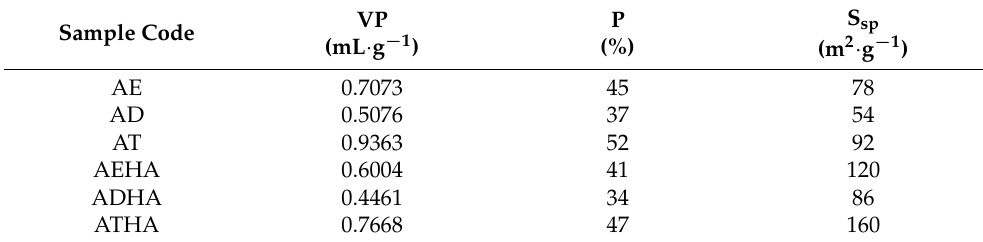
Table 6. Porosity parameters of precursor/hybrid